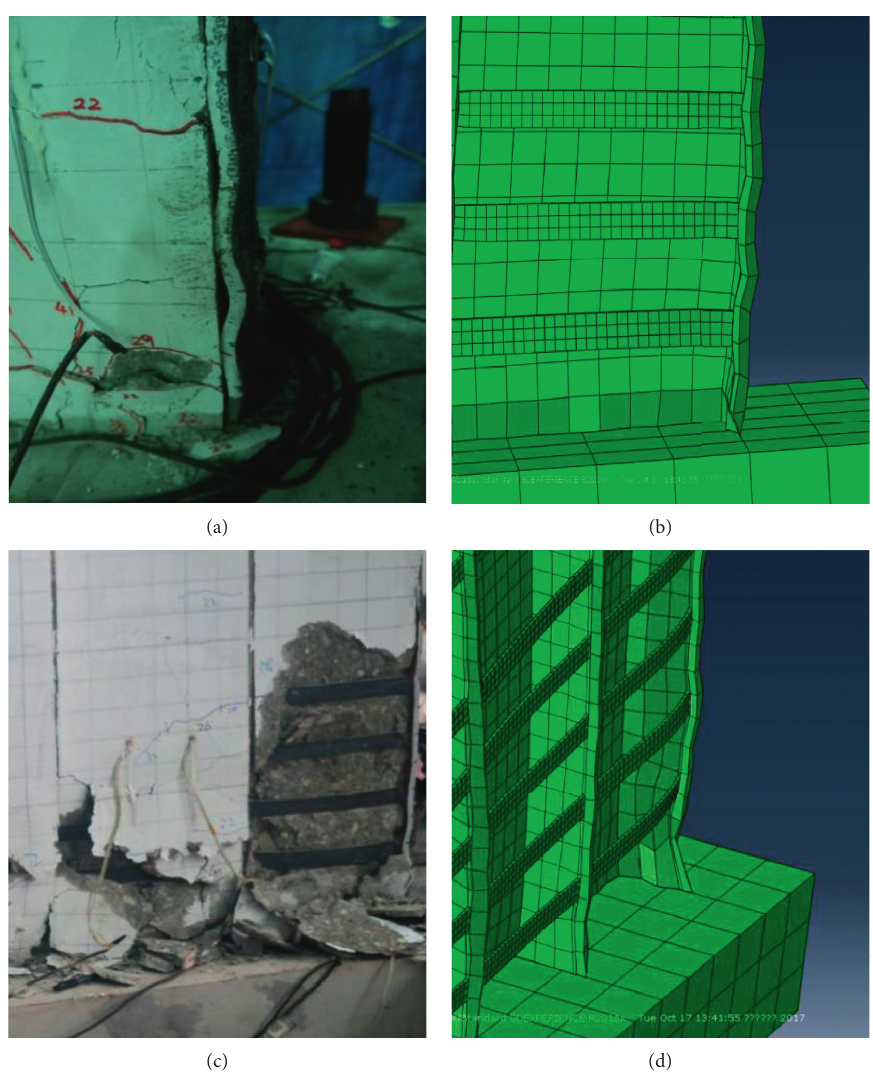
Figure 7: Comparison of the failure modes of the